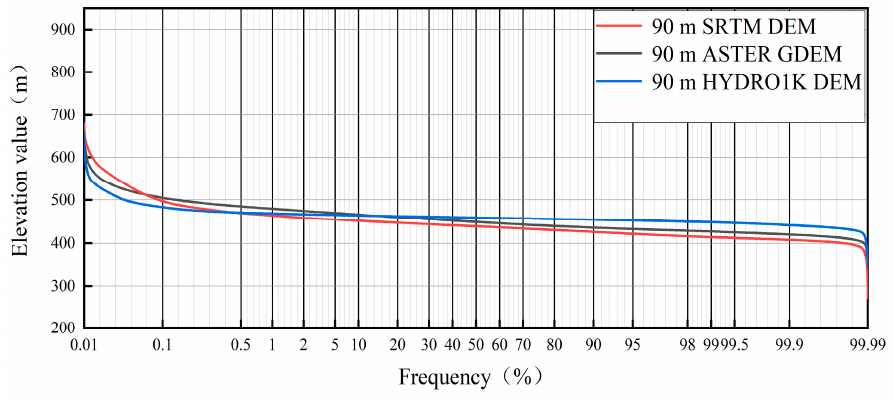
Figure 8. Cumulative distribution of elevation extracted from three kinds of DEM data.